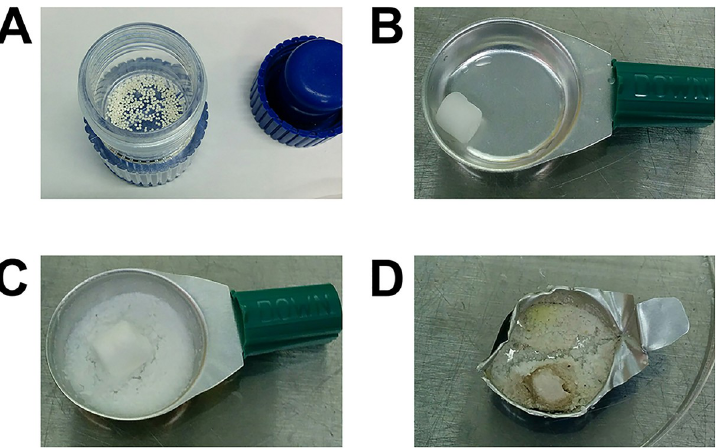
Fig 1. Opiates and injection equipment commonly used by PWID. (A) Pill crusher with uncrushed hydromorphone controlled-release (Hydromorphone-CR) beads (removed from capsule). (B) Unused injection drug preparation equipment consisting of metal cooker and filter. This style of cooker with compressed cotton filter is distributed as part of a provincial harm-reduction initiative from the needle exchange along with clean needles, syringes and water. All cookers collected in the used equipment collection program have been in this style of cooker. (C) Hydromorphone- CR-containing sterile cooker and filter after a single wash in controlled laboratory environment. The large volume of remaining material available for repeat “washes” to get further opioid is visible. (D) Used cookers after three washes (donated by a person who injects drugs) with significant residual Hydromorphone-CR left in cooker. The cooker is often folded to retain residual opiate for later use and a “repeat